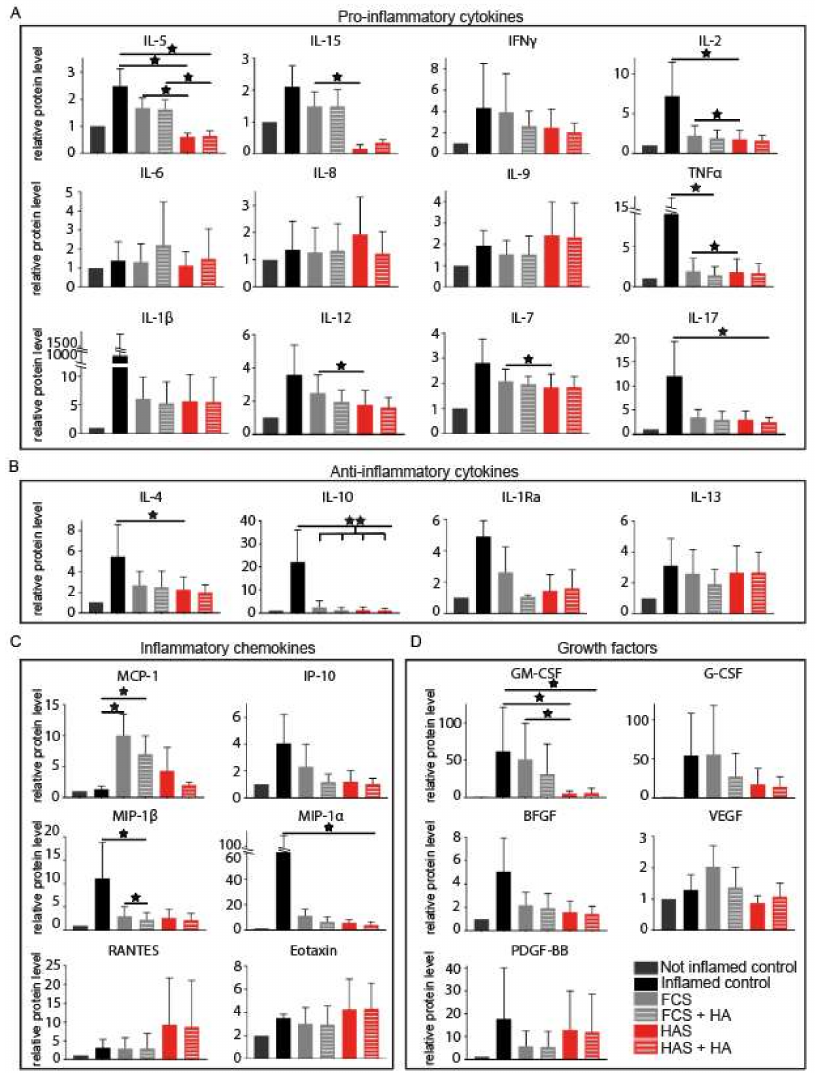
Figure 4. Quantification of cytokines and growth factors from supernatant fluids after 5 days of treatment with HAS and/or HA of a previously inflamed explant human co-culture. Proteins were grouped as ( A ) pro-inflammatory cytokines, ( B ) anti-inflammatory cytokines, ( C ) inflammatory chemokines and ( D ) growth factors. Inflamed (positive) control correspond to samples exposed to inflammation, before any treatment was added at day 0. Not inflamed (negative) control represent samples that were not exposed to inflammatory conditions before day 0. Bars represent arithmetic mean values ± SD (n = 3). Abbreviations: fetal calf serum (FCS), hyperacute serum (HAS), hyaluronic acid (HA), interleukins (IL-), tumor necrosis factor alpha (TNF α ), interferon gamma (IFN γ ), inter- leukin 1 receptor antagonist (IL-1Ra), monocyte chemotactic protein 1 (MCP-1), 10 KDa interferon gamma-induced protein (IP-10), macrophage inflammatory proteins (MIP), regulated upon activation normally T-expressed and presumably secreted (RANTES), granulocyte macrophage colony stimulat- ing factor (GM-CSF), granulocyte colony stimulating factor (G-CSF), vascular endothelial growth factor (VEGF), basic fibroblast growth factor (BFGF) and platelet-derived growth factor subunit B (PDGF-BB). Level of significance where p < 0.05 (*) and p < 0.01